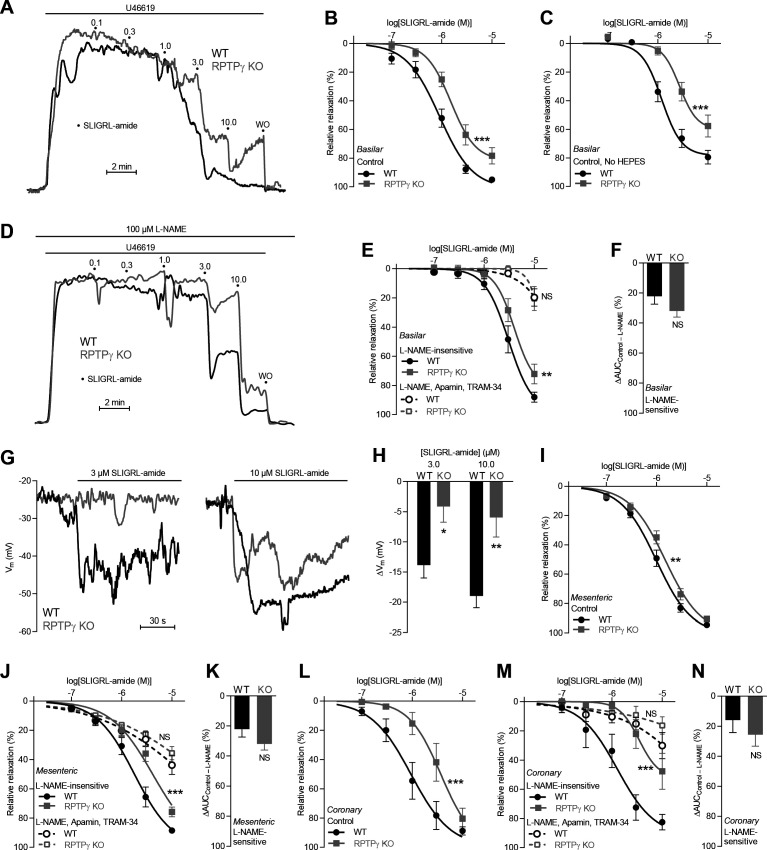
SLIGRL-amide-induced endothelium-dependent vasorelaxation is compromised in basilar, mesenteric, and coronary arteries from RPTPγ KO mice when investigated in presence of CO2/HCO3–.(A and D) Force recordings illustrating SLIGRL-amide-induced vasorelaxation of U46619-contracted basilar arteries under control conditions (A) and after treatment with 100 µM L-NAME (D). The numbers indicate points of cumulative stepwise increases in SLIGRL-amide from 0.1 µM to 10.0 µM. WO indicates the point of washout. The pre-contraction force development in response to U46619 was normalized in order to display relative relaxations. (B, I, and L) SLIGRL-amide-induced relaxations of basilar (B, n = 12), mesenteric (I, n = 11), and coronary (L, n = 7) arteries from RPTPγ KO and WT mice under control conditions, that is without inhibitors of endothelial function. (C) Experiment similar to that in panel B but performed in a CO2/HCO3–-containing solution without HEPES (n = 8). (E, J, M) SLIGRL-amide-induced relaxations of basilar (E, n = 12), mesenteric (J, n = 11), and coronary (M, n = 7) arteries from WT and RPTPγ KO mice after treatment with 100 µM L-NAME alone or in combination with 50 nM apamin and 1.0 µM TRAM-34. (F, K, and N) SLIGRL-amide-induced L-NAME-sensitive relaxations of basilar (F, n = 12), mesenteric (K, n = 11), and coronary (N, n = 7) arteries from RPTPγ KO and WT mice calculated as the difference in area under the curve (AUC) between the concentration-response curves with and without L-NAME. (G and H) Original recordings (G) and summarized data (H, n = 8–9) from basilar arteries showing vascular smooth muscle cell membrane potential (Vm) responses to SLIGRL-amide in presence of 100 µM L-NAME. In panel B, C, E, I, J, L, and M, the relative relaxations were fitted to sigmoidal curves and compared using extra sum-of-squares F tests. In panel F, K, and N, the relative relaxations were compared by unpaired two-tailed Student’s t-test. In panel H, membrane potential responses were compared by two-way ANOVA followed by Sidak’s post-test. *p<0.05, **p<0.01, ***p<0.001. NS: not significantly different vs WT.